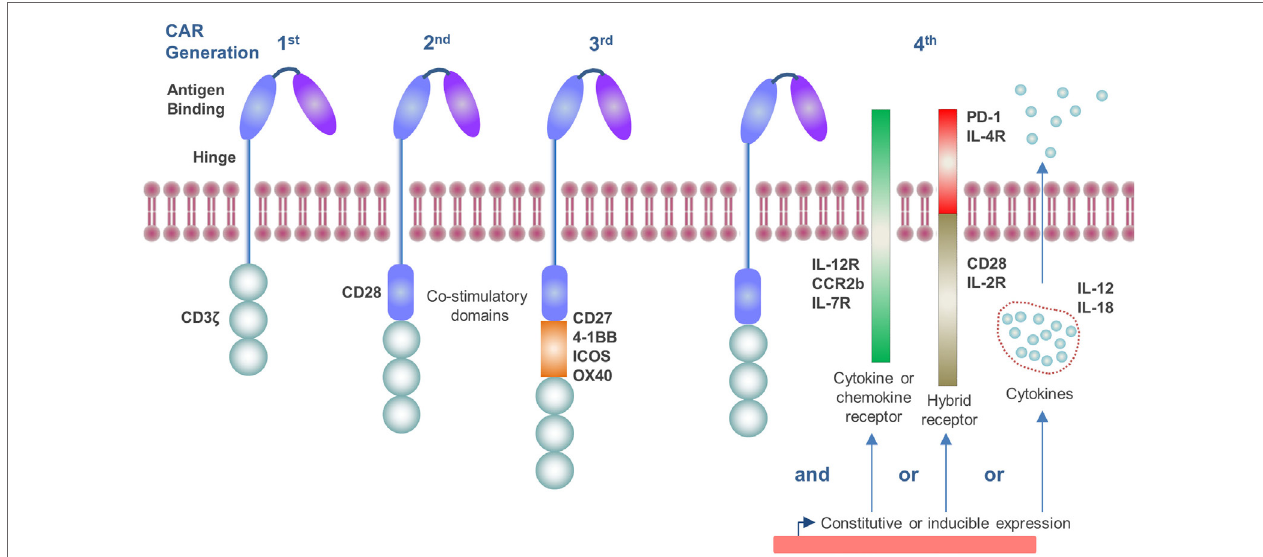
FigURe 1 | Generations of chimeric antigen receptor (CAR) molecules. First generation CARs contain a CD3 ζ signaling endodomain. Second and third generation CARs, in addition to the CD3 ζ domain, incorporate CD28 (second generation) or two or more additional co-stimulatory domains which may include CD27, 4-1BB, ICOS, or OX40 (third generation). Fourth generation CARs include constitutive or inducible expression of co-receptors or soluble cytokines alongside that of the CAR molecule which further promote T-cell activation.